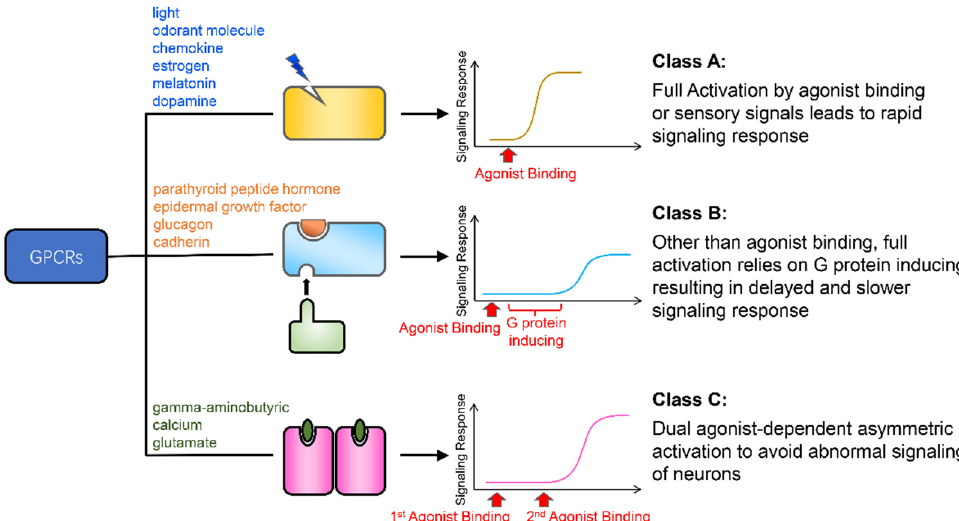
Figure 5. Summary of the conclusions of the work. The yellow, light blue, and magenta rectangles represent the class A, B, and C GPCRs, respectively. The blue flash, orange semicircle, and green oval are the agonists of these three classes of receptor. The text to the left of the cartoons lists examples of signals that activate these receptors. The curves to the right of the cartoons are models of the signaling response curves of these receptors.